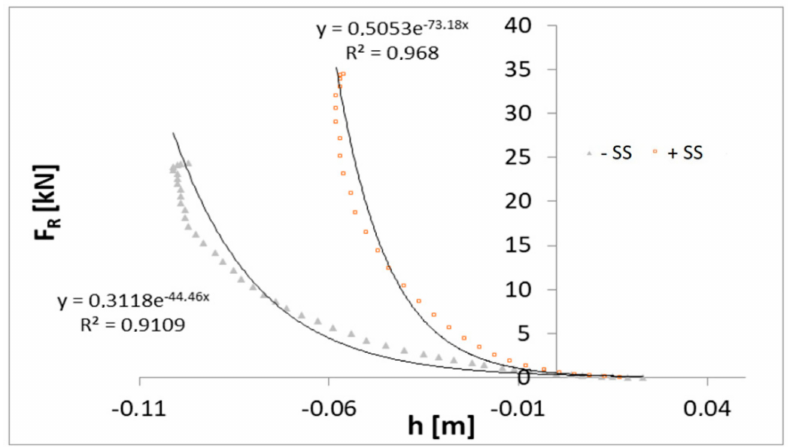
Figure 13. Correlations between the impact force F R and the height h at the drop hammer weight of 100 kg and the drop height of 1.4 m.